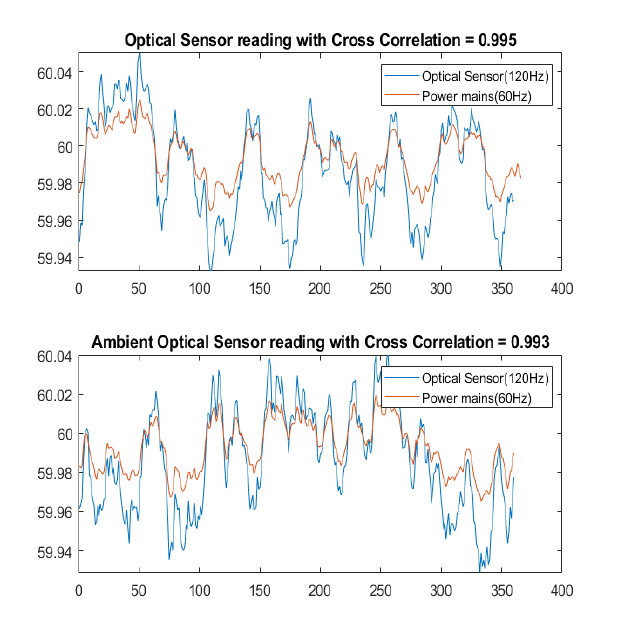
Figure 1. Optical sensor reading collected under direct mains powered light source and ambient light. Compared with simultaneous power recording using Cross Correlation